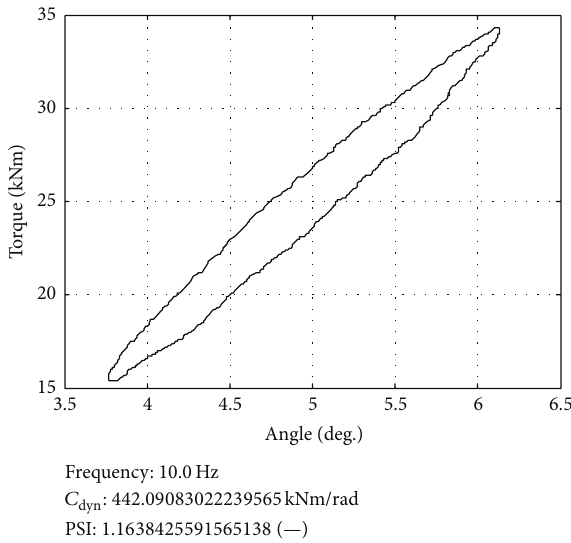
Figure 9: Dynamic stiffness curve of the elastic